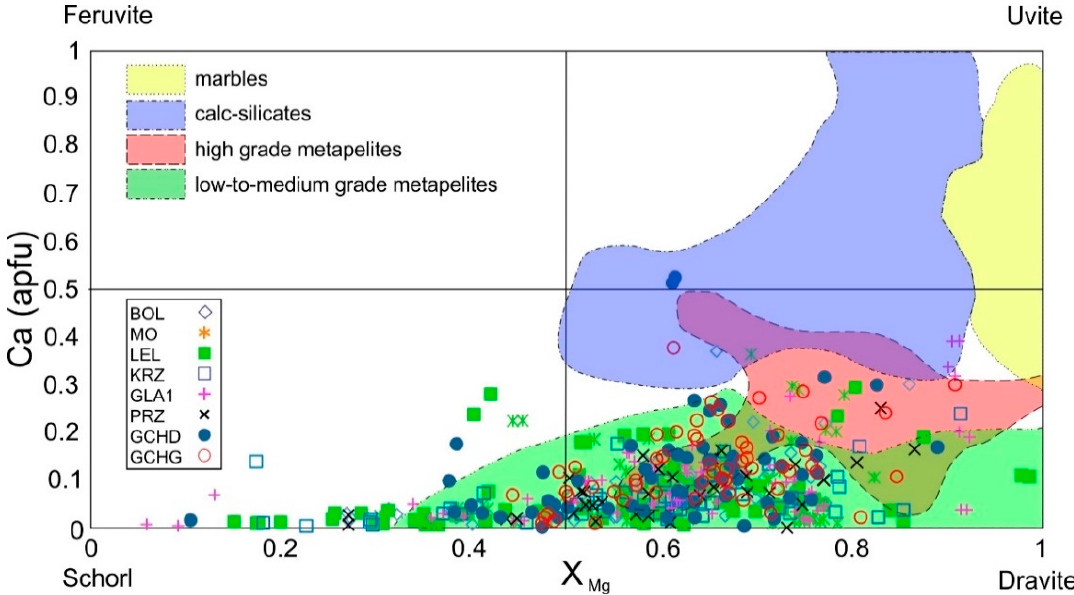
Figure 6. X Mg vs Ca discrimination diagram of Henry and Dutrow [91] showing mineral chemistry of the examined tourmaline grains from the Albian sands of the Miechów area.